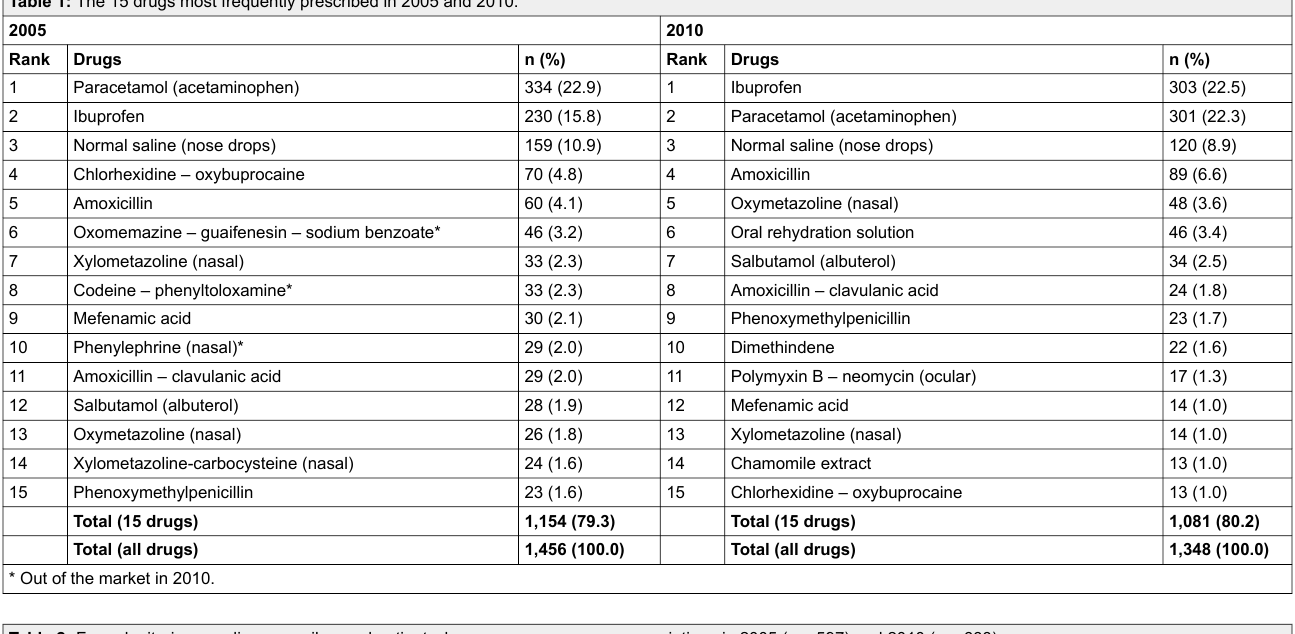
Table 1: The 15 drugs most frequently prescribed in 2005 and 2010.